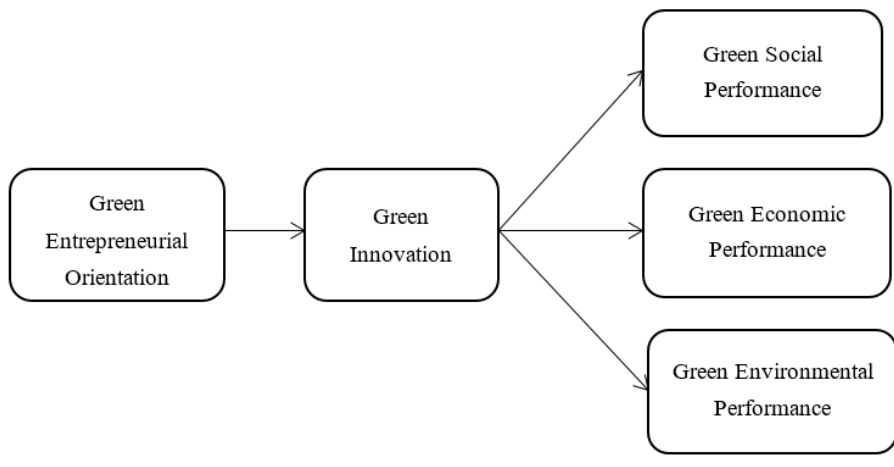
Figure 1. Conceptual Framework.